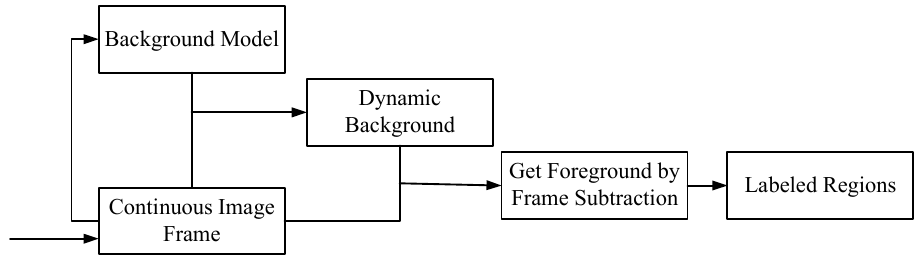
Figure 2. The process of background